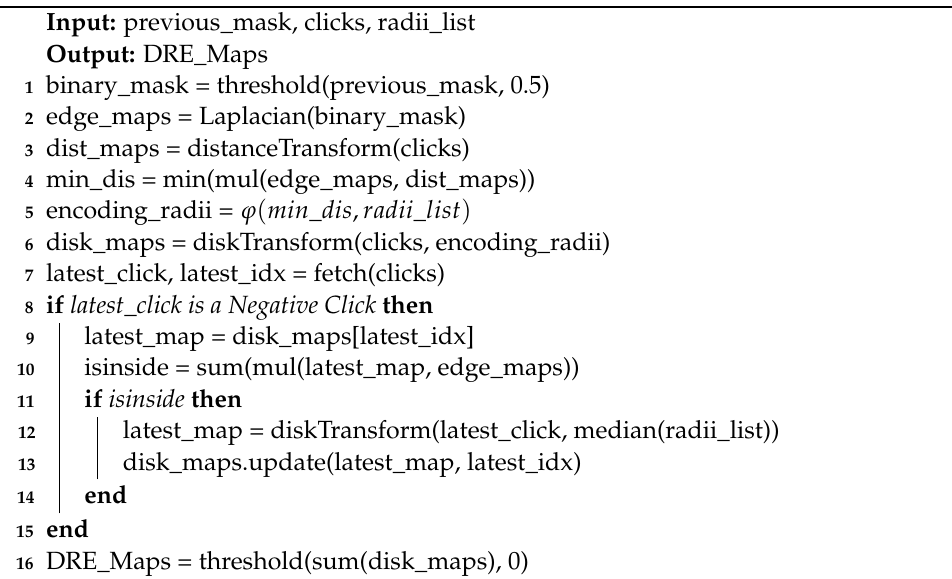
Algorithm 1: Dynamic Radius